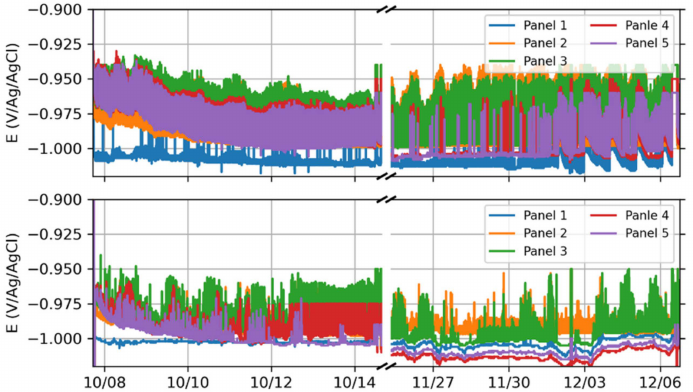
Figure 6. Polarization potentials: Clean ( top ) and previously fouled and corroded ( bottom ).